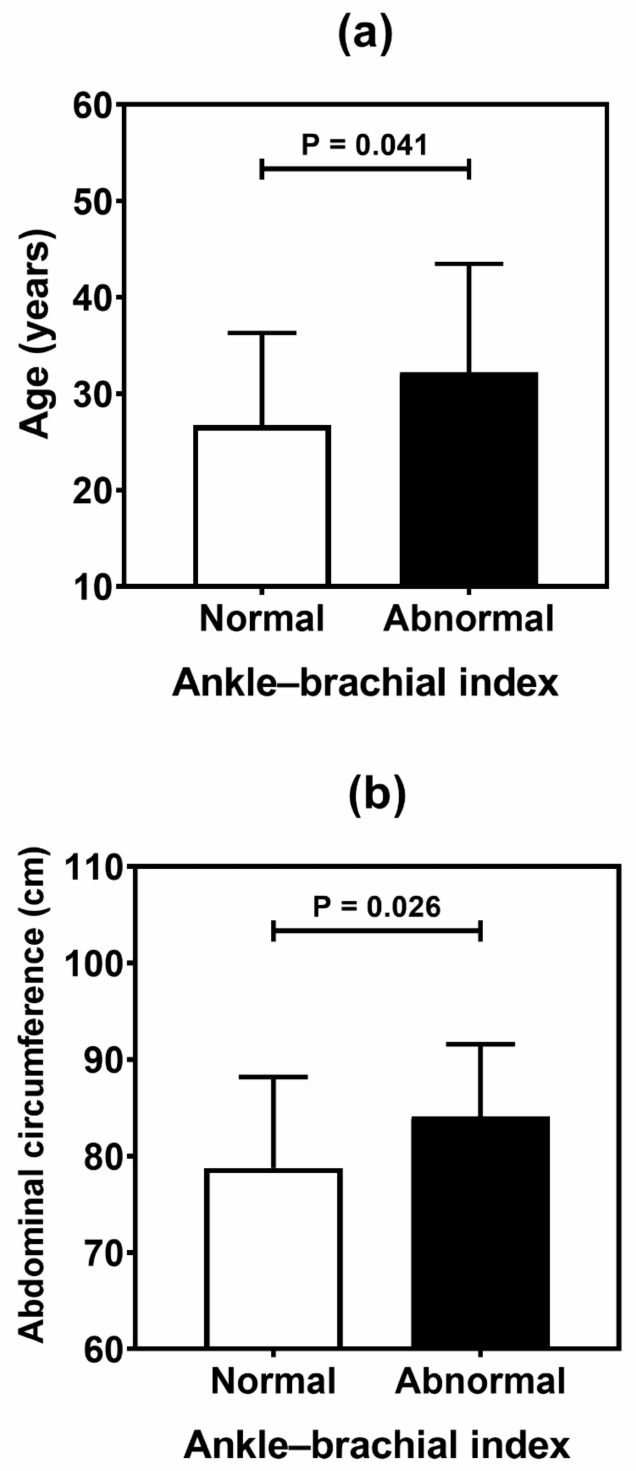
Figure 4. Comparative analysis (mean and standard deviation) of age ( a ), and abdominal circumfer- ence ( b ) in type 1 diabetes patients according to the ankle-brachial index. p values were determined by independent t